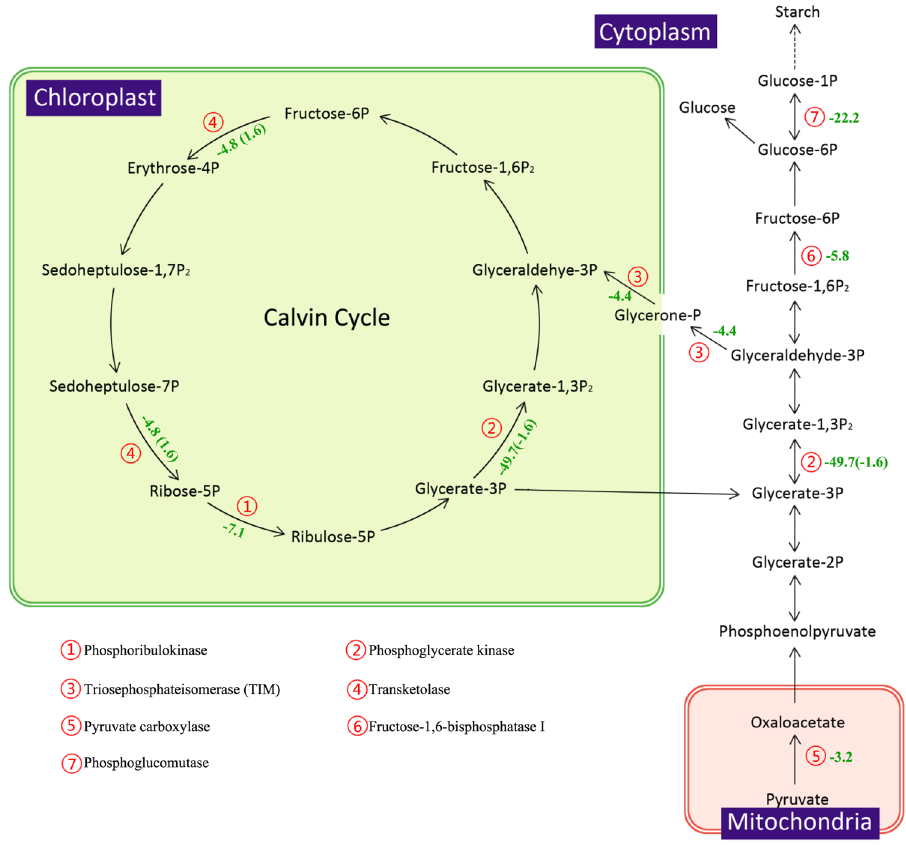
Figure 4. The KEGG calvin cycle and starch synthesis pathway for T. pseudonana during N depletion compared to N replete conditions (ND vs. NR). The serial number represent the related enzyme and the negative number indicate the down-expressed fold change of the genes (The opposite is up-expressed). The Inside the parentheses is the protein fold